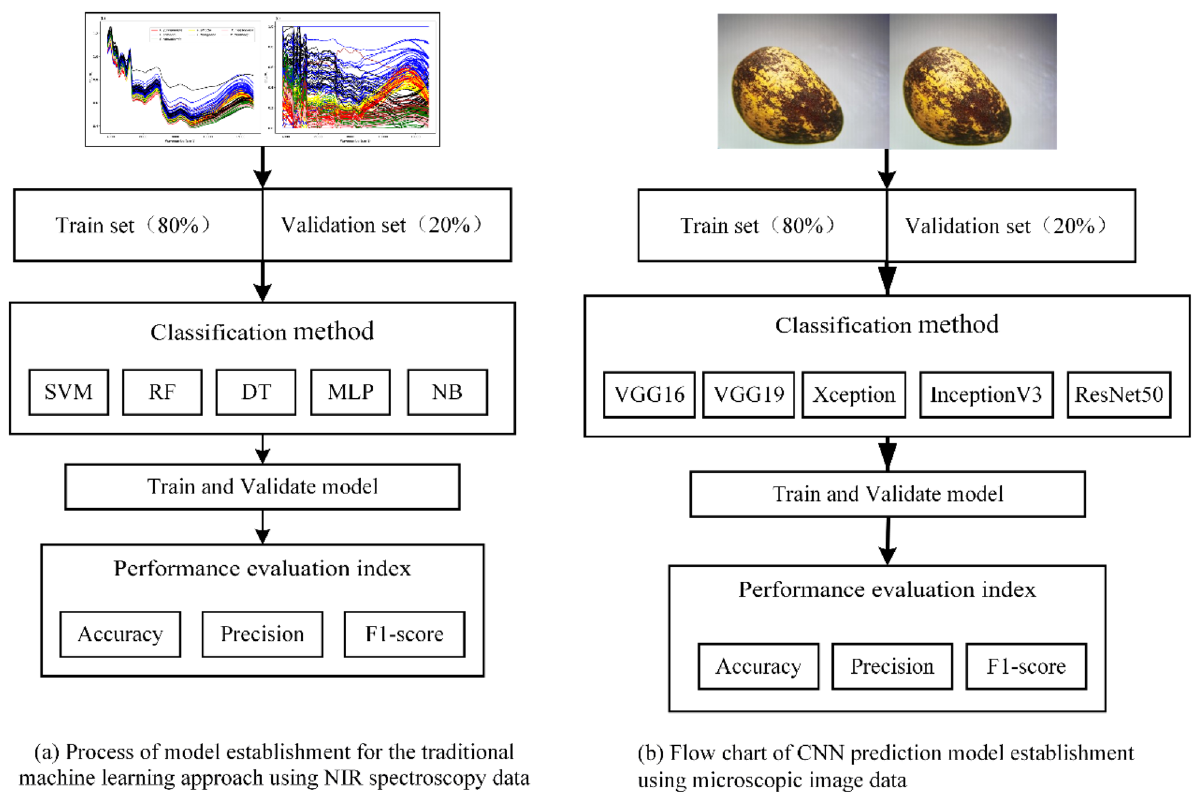
Figure 8. Experimental design process for image recognition and NIR spectroscopy. ( a ) Process of traditional machine learning classification model establishment using NIR spectroscopy data. ( b ) Process of deep learning classification model establishment using image